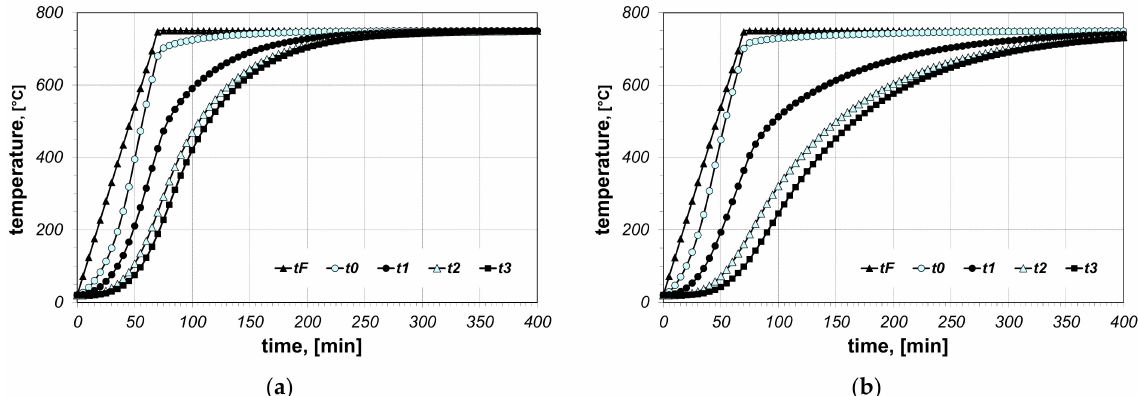
Figure 6. Calculated values of temperatures for heating of a 5 × 20 bar bundle with horizontal arrangement: ( a ) results obtained for R ct-min , ( b ) results obtained for R ct-max .